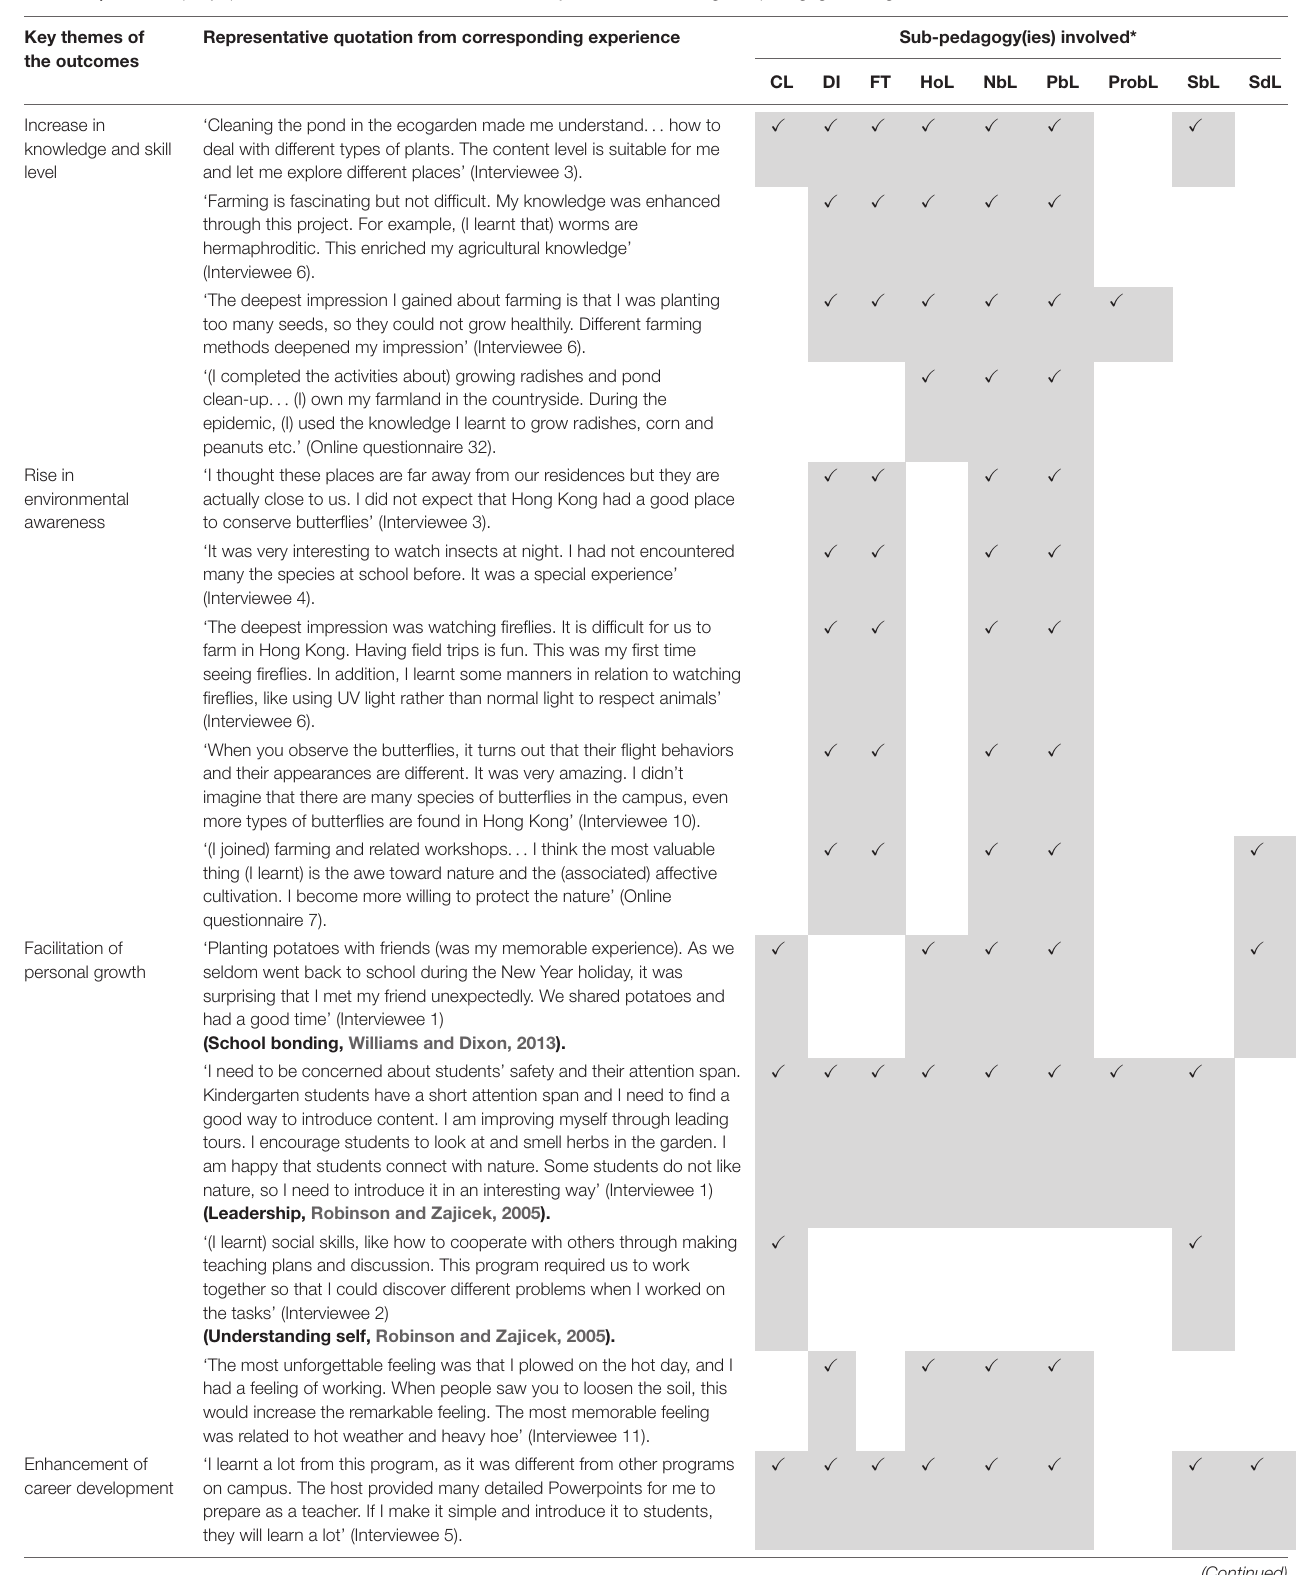
CL DI FT HoL NbL PbL ProbL SbL SdL